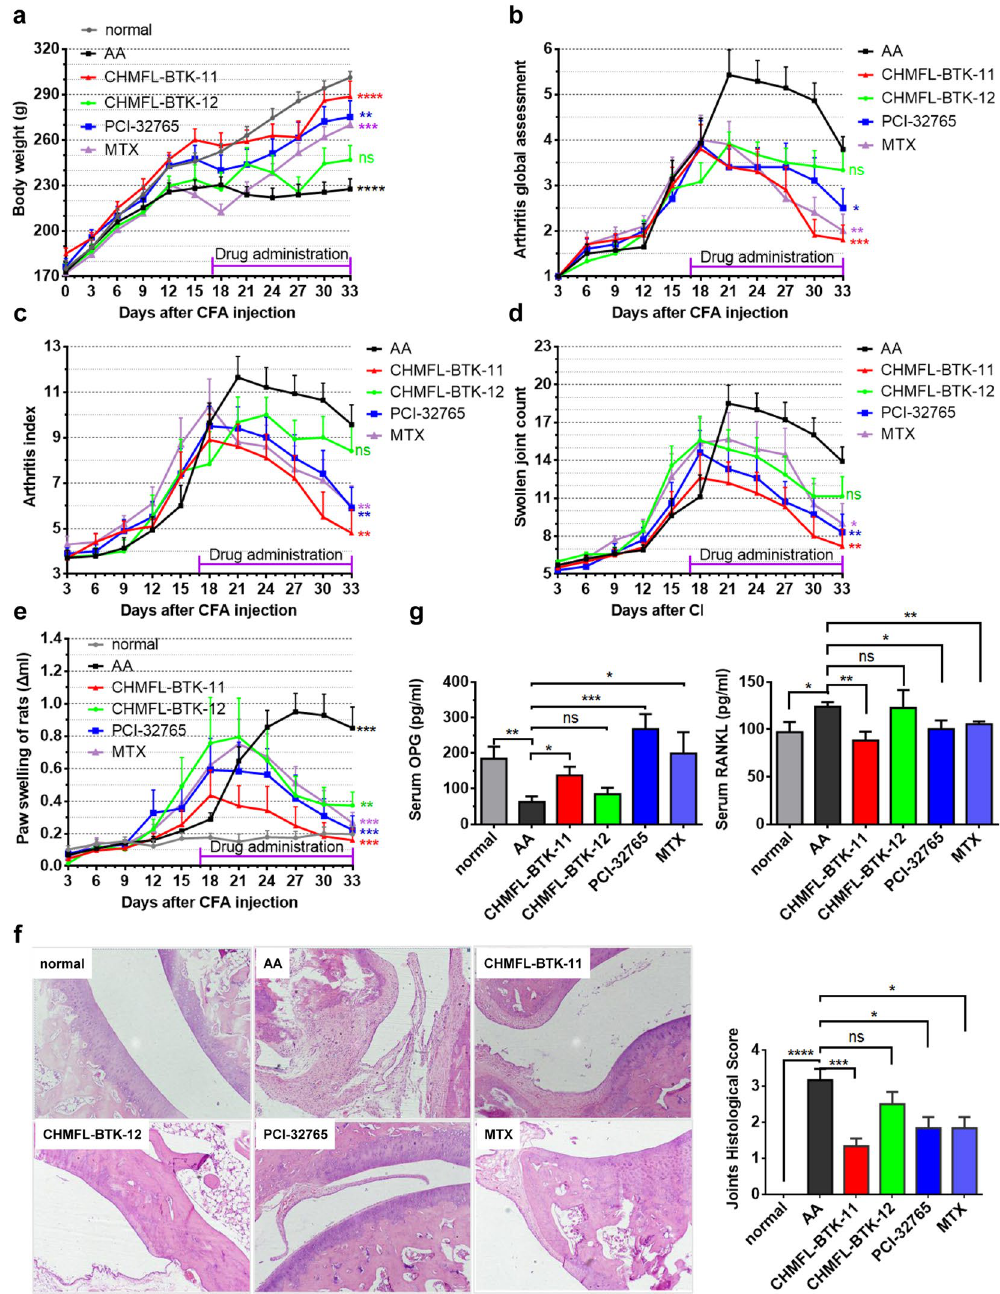
Figure 3. CHMFL-BTK-11 ameliorates symptoms in an adjuvant arthritis (AA) rat model. ( a – e ) The body weight ( a ), arthritis global assessment ( b ), arthritis index ( c ), swollen joint count ( d ), and paw swelling of rat ( e ) of AA rats. S.D. rats were intradermal injected with 0.1 ml 10 mg/ml complete Freund’s adjuvant (CFA) into the right rear foot plantar to develop AA rat model. saline injection set as normal control. Drug administration by i.p . injection daily begin at day 17, including DMSO (vehicle AA control), 12.5 mg/kg/d CHMFL-BTK-11, 25.0 mg/kg/d CHMFL-BTK-12, 25.0 mg/kg/d PCI-32765, and 0.5 mg/kg/d MTX. ( f ) Histology of ankle joint from AA rats. Data shows HE staining and quantification. (Original magnification 100 × ). ( g ) Serum OPG and RANKL measurement from AA rats after drug administration. Student’s t-test was used and data were representative of at least 2 independent experiments. ns, P > 0.05, * P < 0.05, ** P < 0.01, *** P < 0.001, and **** P <